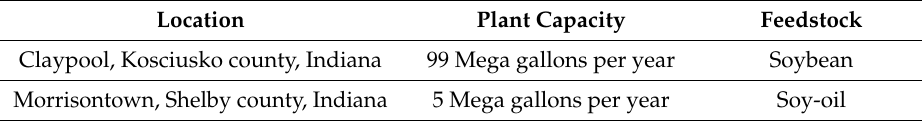
Table 1. Biodiesel Production Capacity in Indiana, 2013